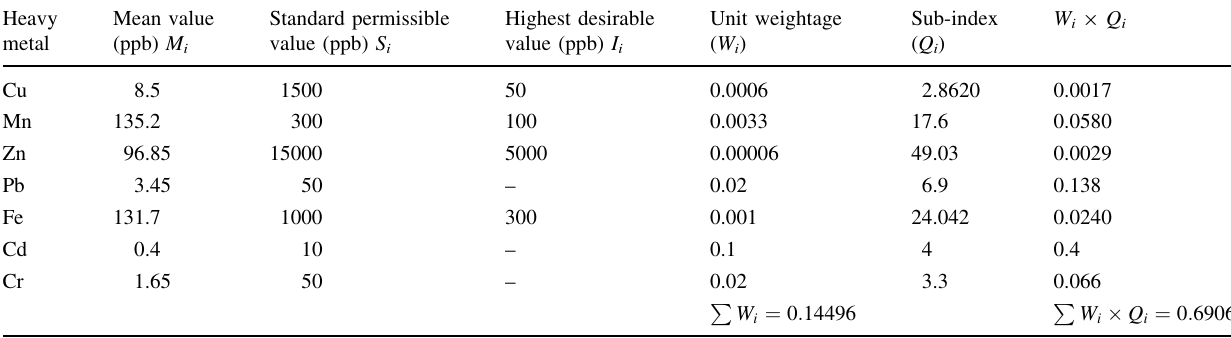
Table 3 HPI calculation for groundwater of Dhanbad Town in 2011 Heavy metal